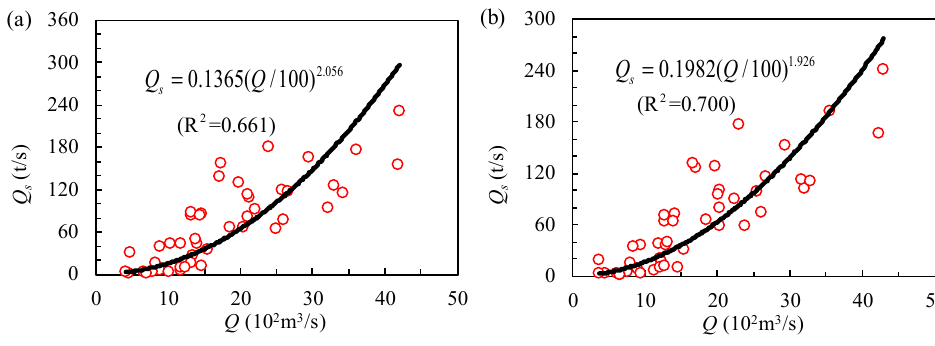
Figure 7. Sediment rating curves at sections of: ( a ) HYK; ( b ) JHT.